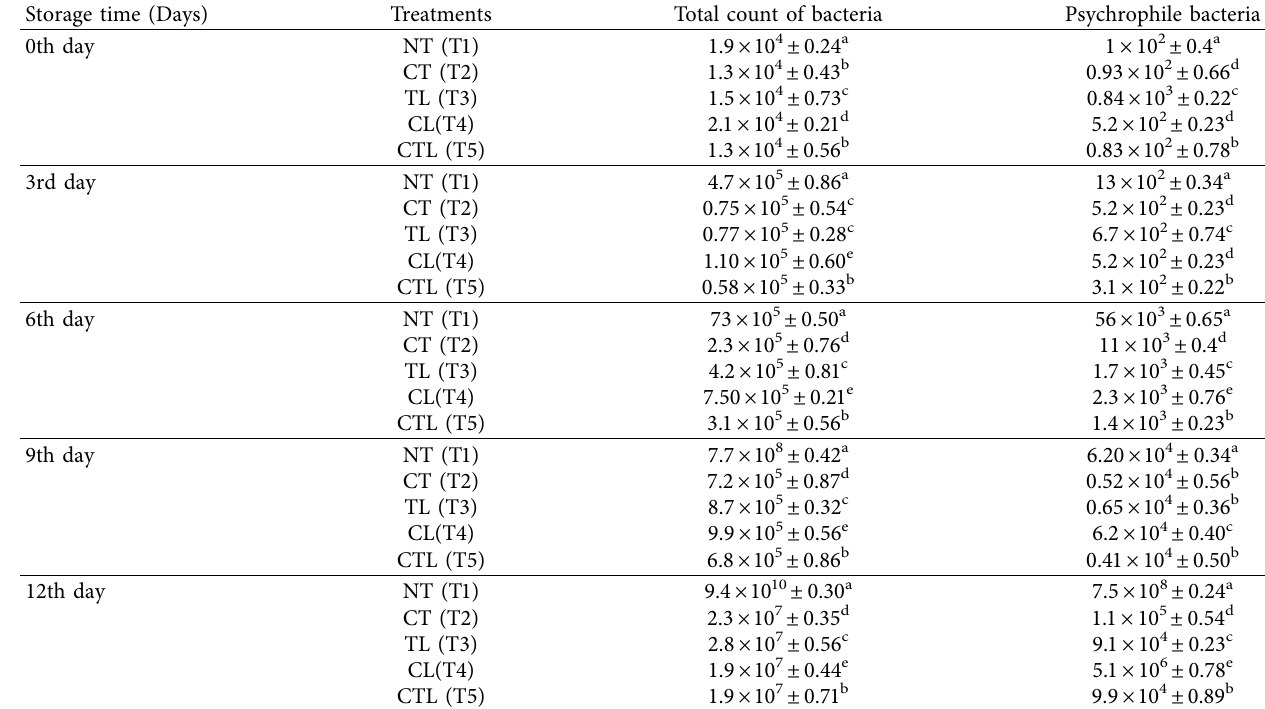
Figure 9: Percentage of acidity content in the carp fillet immersed in mixed different extracts of turmeric, cinnamon, and lemon at 4 ° C. Table 2: Bacterial analysis (CFU/gr) of common carp tissue immersed in mixed different extracts of turmeric, cinnamon, and lemon before cold